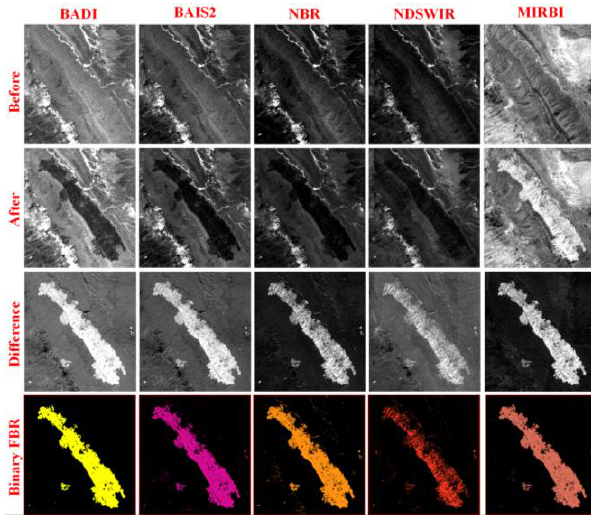
Figure 6. Burned area detection indices related to the study area; pre-fire (First row), post-fire (Second row), difference maps (Third row), and binary maps (End row).